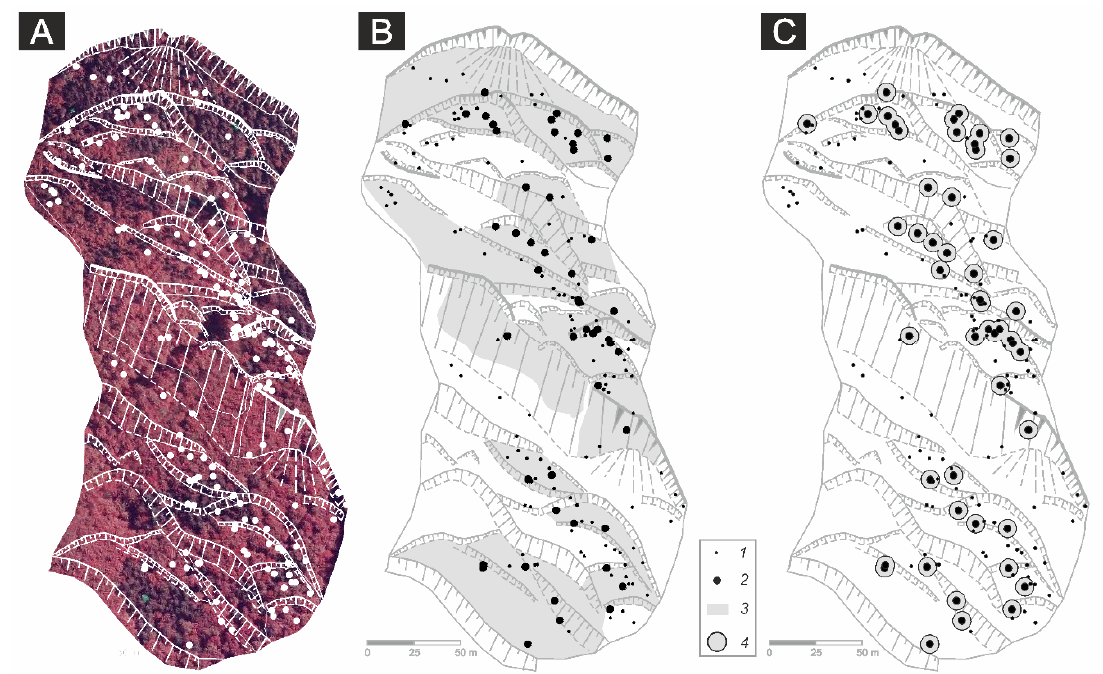
Figure 3. Afforestation of the Mazák landslide area ( A) based on the infrared picture; and the area affected by landslide reactivation in a case year 1985 based on homogenous morphological units ( B ) and tree buffers ( C ) (1 – position of sampled trees, 2 – position of trees with landslide signal in particular year, 3 – reactivated area during particular event, 4 – tree buffer).